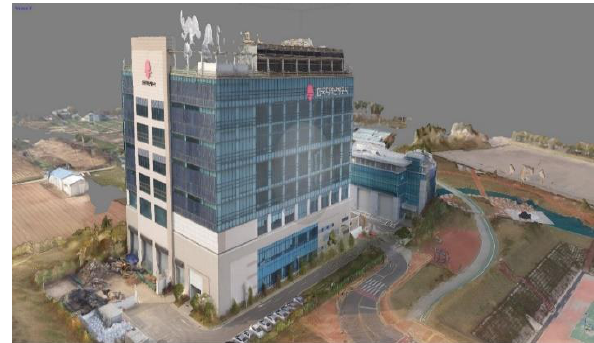
Figure 4 The 3D model generated by combining oblique and Nadir